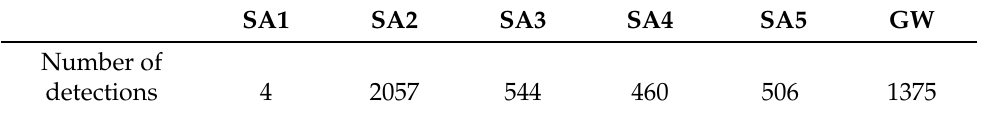
Table 2. Number of overloaded T2S3 according to the single axles and the gross-weight for the period of time from 5 January 2021 to 21 January 2021. The second axle is considered as overloaded above 12T. The limit weight for the other axles is 9T and 44T for the gross-weight.